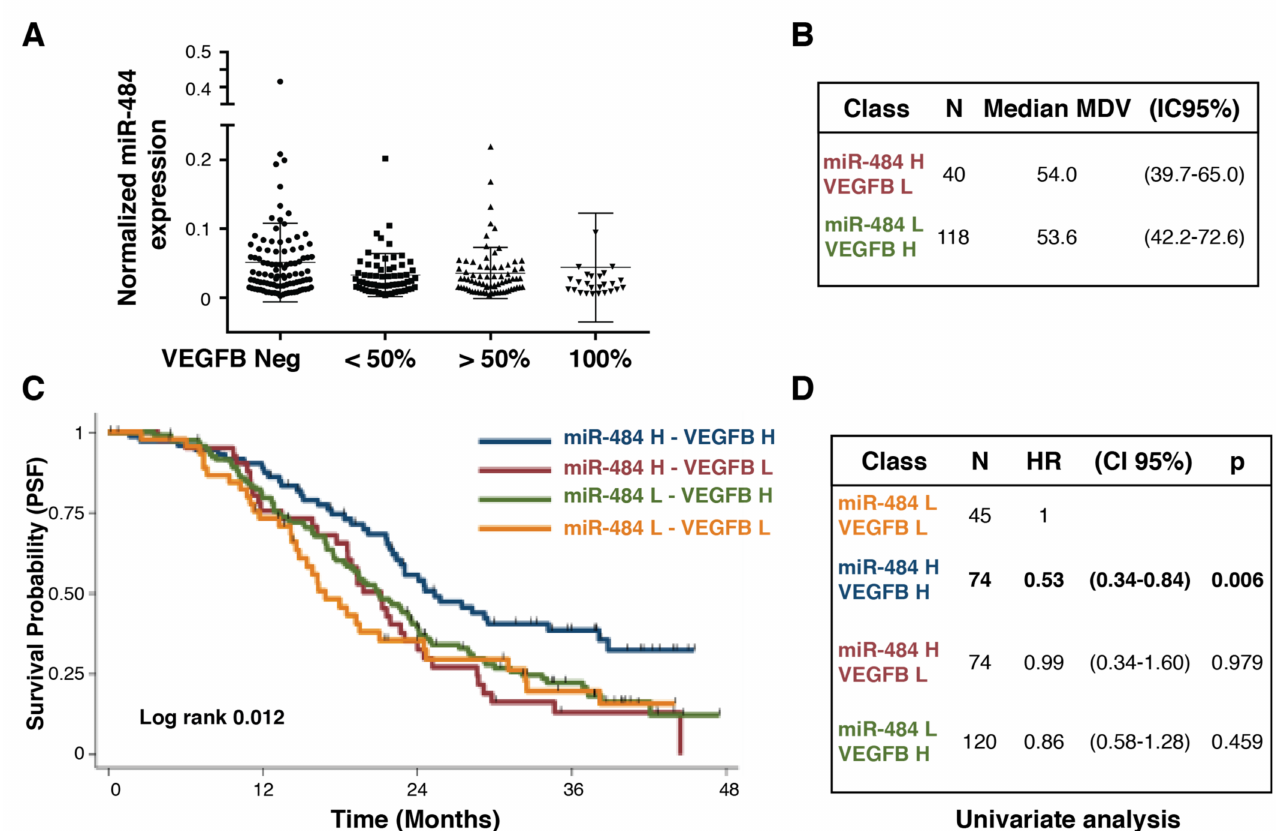
Figure 3. Evaluation of the prognostic role of miR-484/VEGFB combined expression. ( A ). Dot plot reporting the expression of miR-484 in EOC samples divided based on the expression of VEGFB (Neg = negative samples; <50% samples expressing VEGFB in less than 50% of the cells; >50% samples expressing VEGFB in 50–90% of the cells. 100% samples with all (i.e., 90–100%) cells expressing VEGFB. ( B ). Evaluation of MVD (microvessel density) in samples expressing high levels of miR-484 (miR-484 H) and low levels of VEGFB (VEGFB L) or expressing low levels of miR-484 (miR-484 L) and high levels of VEGFB (VEGFB H) ( C ). Kaplan–Meier analysis evaluating the progression free survival of MITO16A-MANGO OV2 patients, divided based on the expression of VEGFB and miR-484. ( D ). Table reporting the univariate analysis of the different group analyzed in C. HR = hazard ratio. CI = confidence